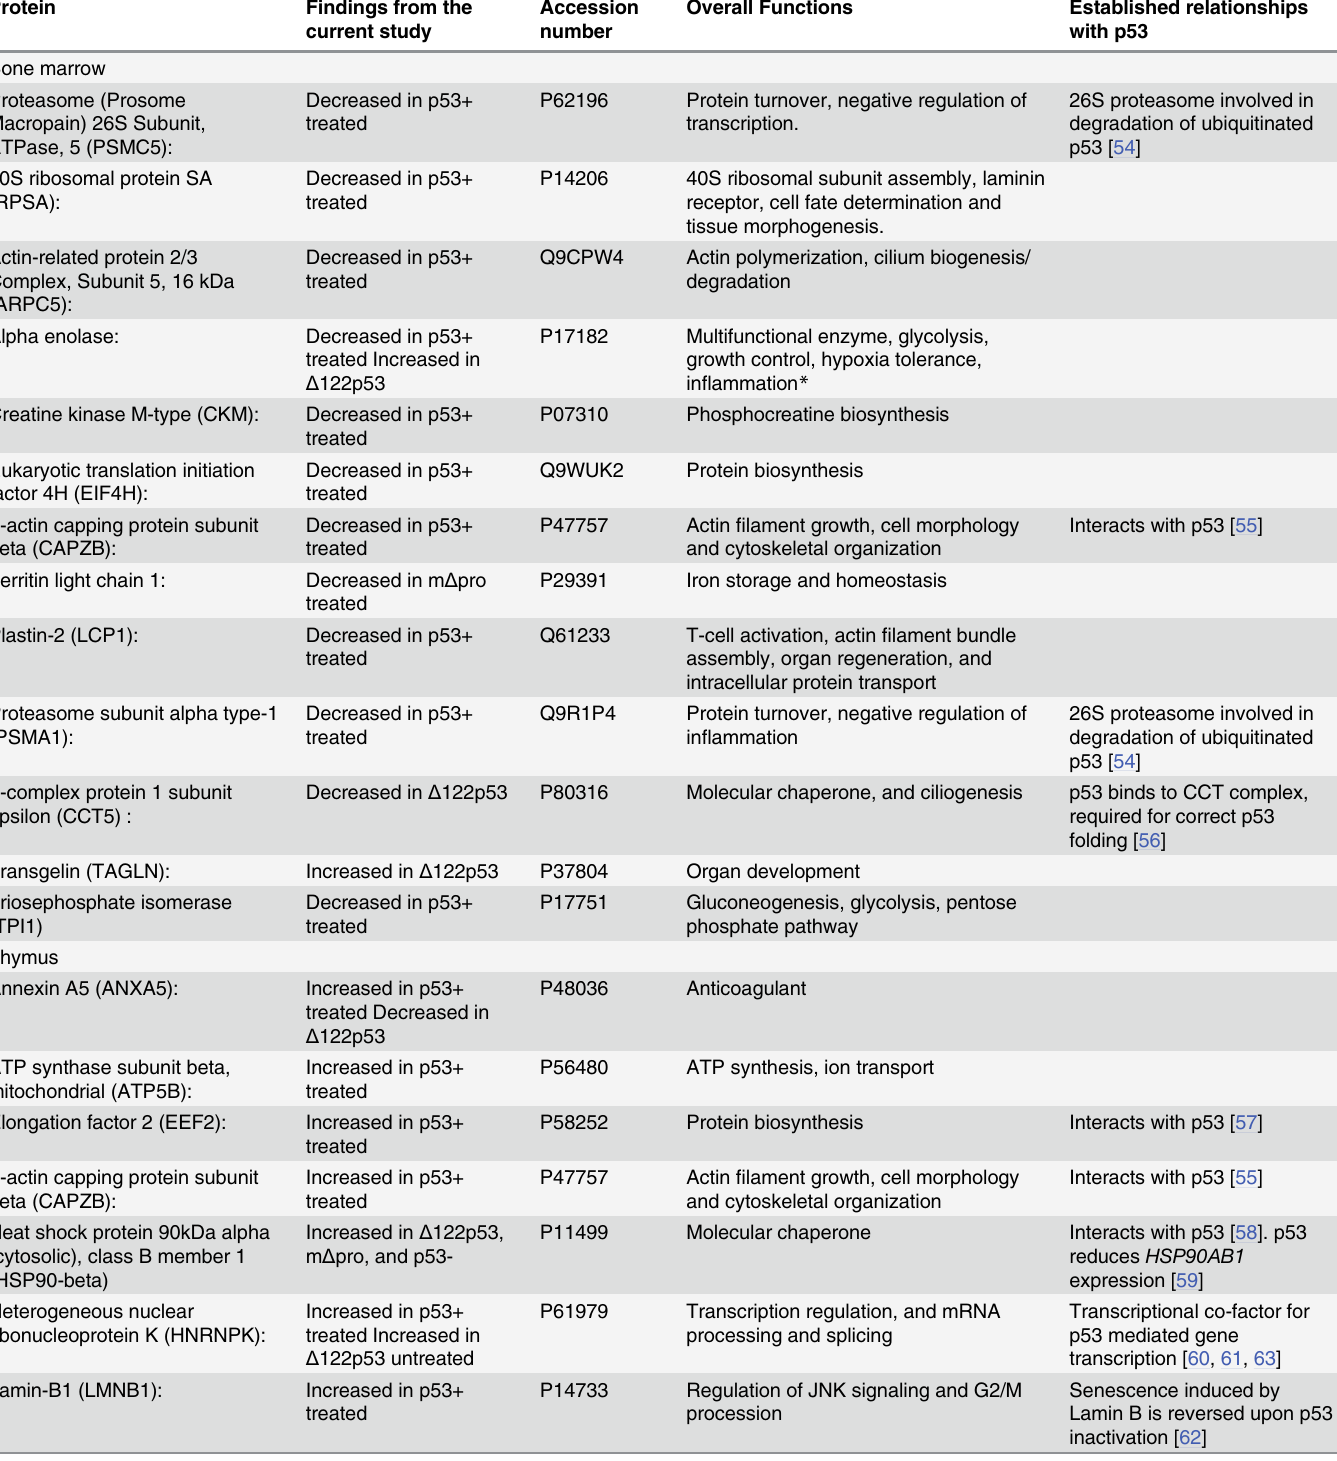
Table 1. List of proteins differentially regulated amongst different p53 genotypes.